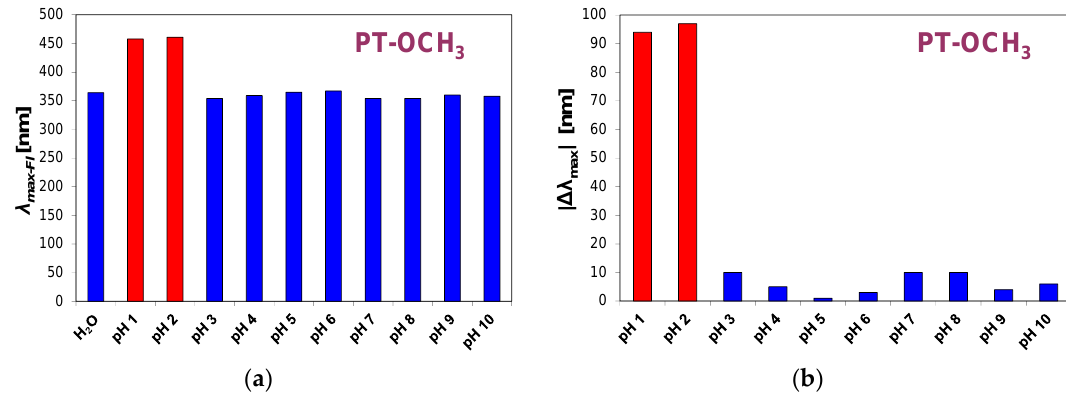
Figure 13. ( a ) Position of maximum fluorescence intensity for compound PT-OCH 3 in in distilled water and pH in a range of 1 – 10. ( b ) Difference between the position of the maximum fluorescence of the PT-OCH 3 compound in the reference sample (in distilled water) and the maximum of fluorescence in buffers at different pH.